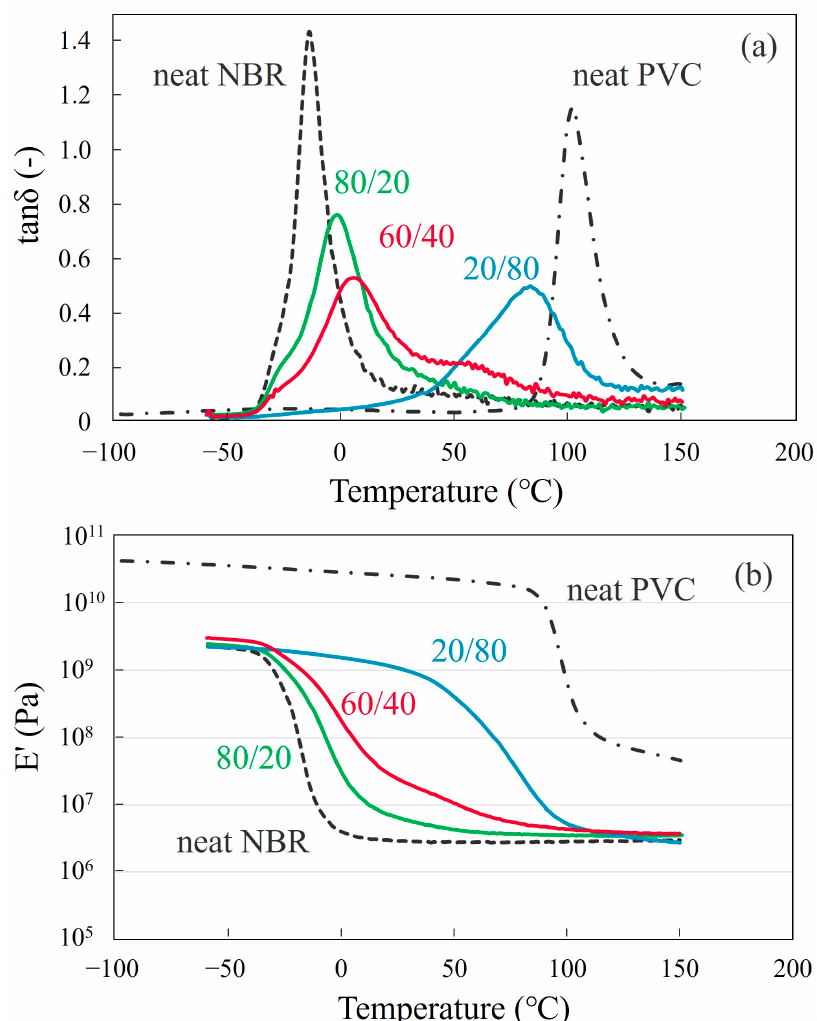
Figure 4. Dynamic mechanical analysis thermograms at a heating rate of 5 °C/min for the melt- mixed NBR/PVC blends at various compositions and the neat component polymers: ( a ) tan δ ; ( b ) storage modulus E ′ .